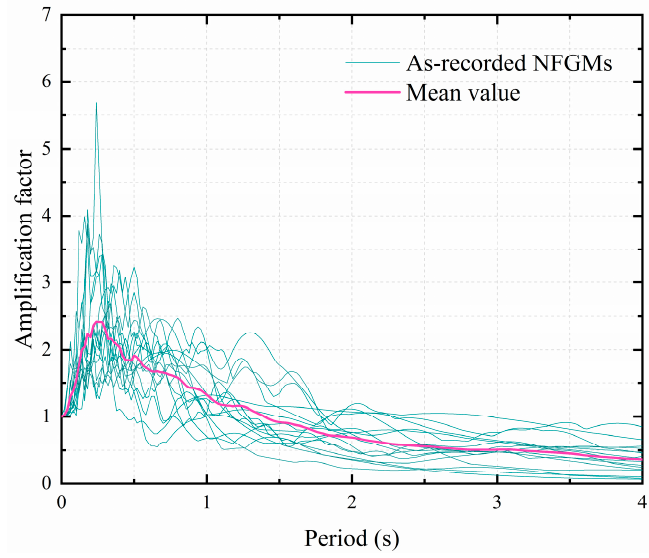
Figure 3. Acceleration spectrum for as-recorded NFGMs.